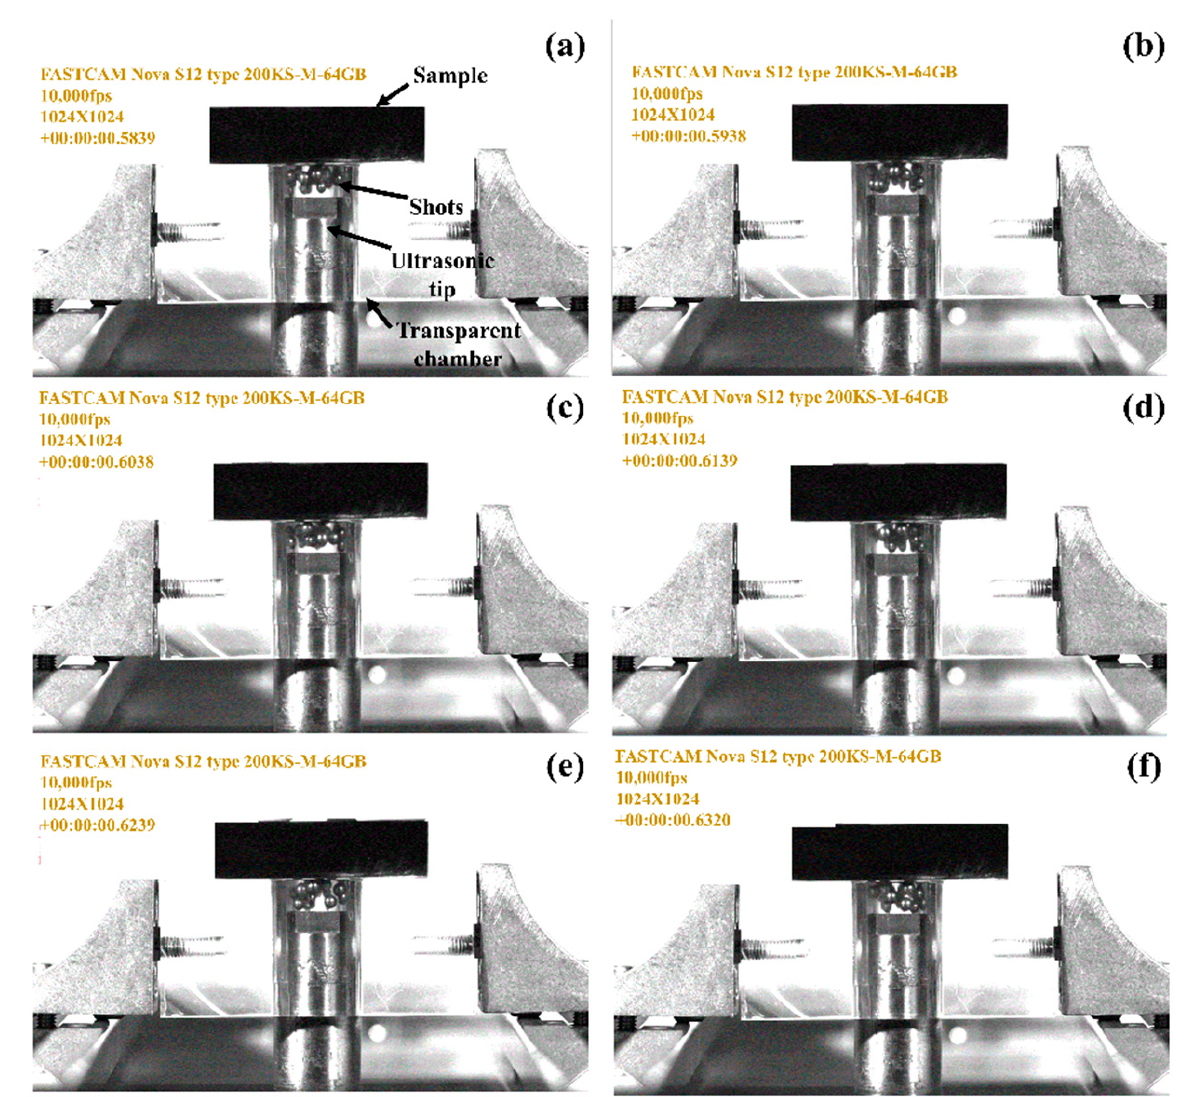
Figure 14. Motion of shots during ultrasonic shot peening process of 316L stainless steel captured by high-speed camera: ( a ) position of steel shots at peening time of 0.5839 s; ( b ) position of steel shots at peening time of 0.5938 s; ( c ) position of steel shots at peening time of 0.6038 s; ( d ) position of steel shots at peening time of 0.6139 s; ( e ) position of steel shots at peening time of 0.6239 s; ( f ) position of steel shots at peening time of 0.6320 s.